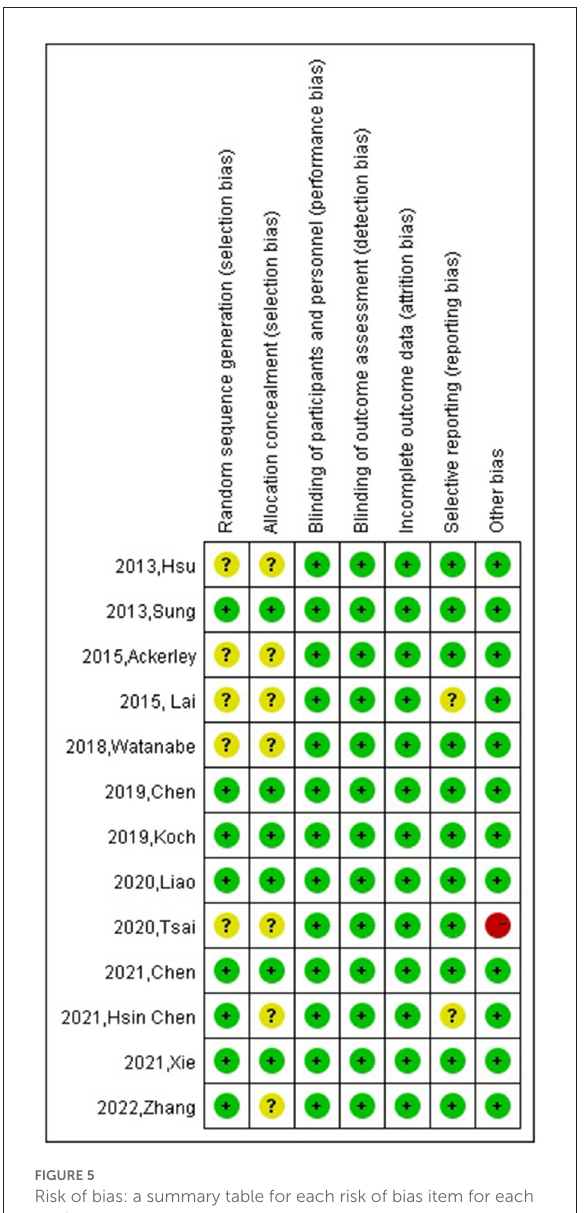
FIGURE5 Risk of bias: a summary table for each risk of bias item for each